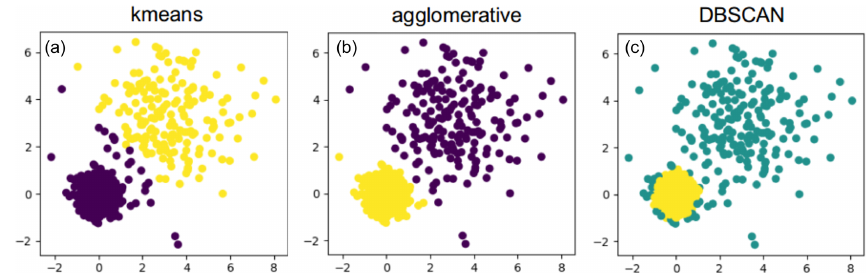
Figure 5. Example of clustering of data with two clusters with different variance: the k -means algorithm separates them but adds a few points in the middle to the purple cluster instead of the yellow one (a) . Agglomerative clustering separates both clusters according to their variances (b) and DBSCAN detects the cluster with low variance and high point density (yellow) and discards all other points as outliers (turquoise) (c)